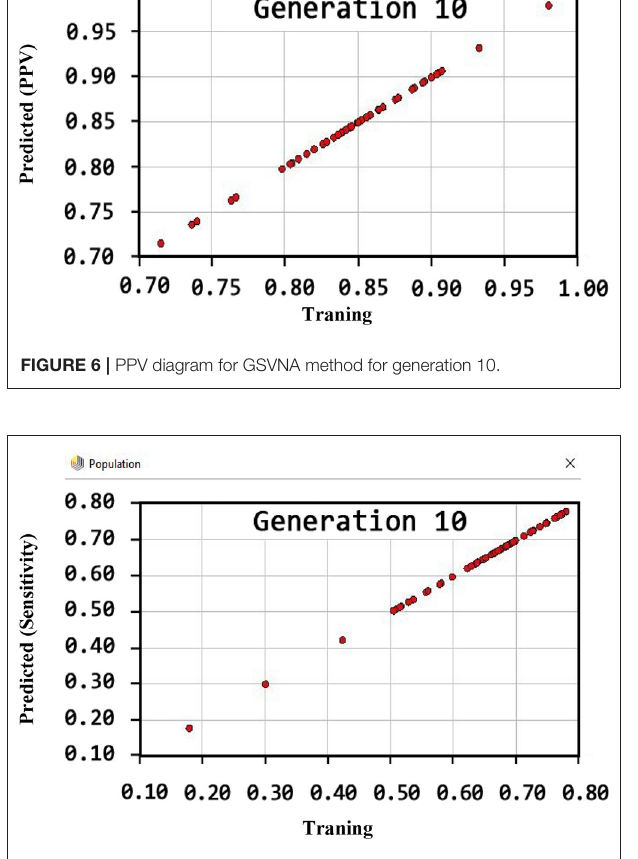
achieved as 92.4, 89, and 82.1% for LSVM, SVM with ANOVA, and LIBSVM with RBF methods, respectively. The ROC curve for